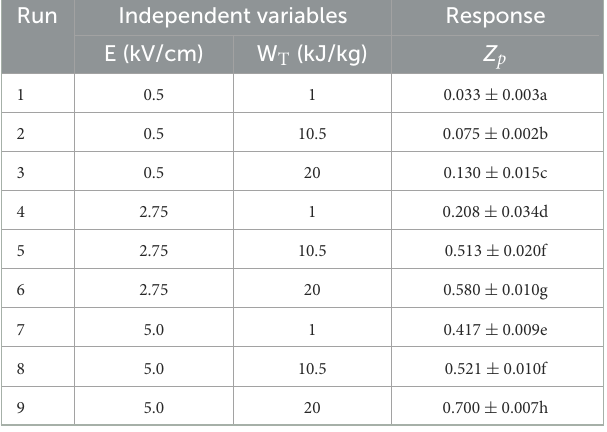
TABLE 1 Effect of of the two independent factors (E, W T ) investigated on the response variable ( Z p ) of the PEF treated grape pomace tissues according to the